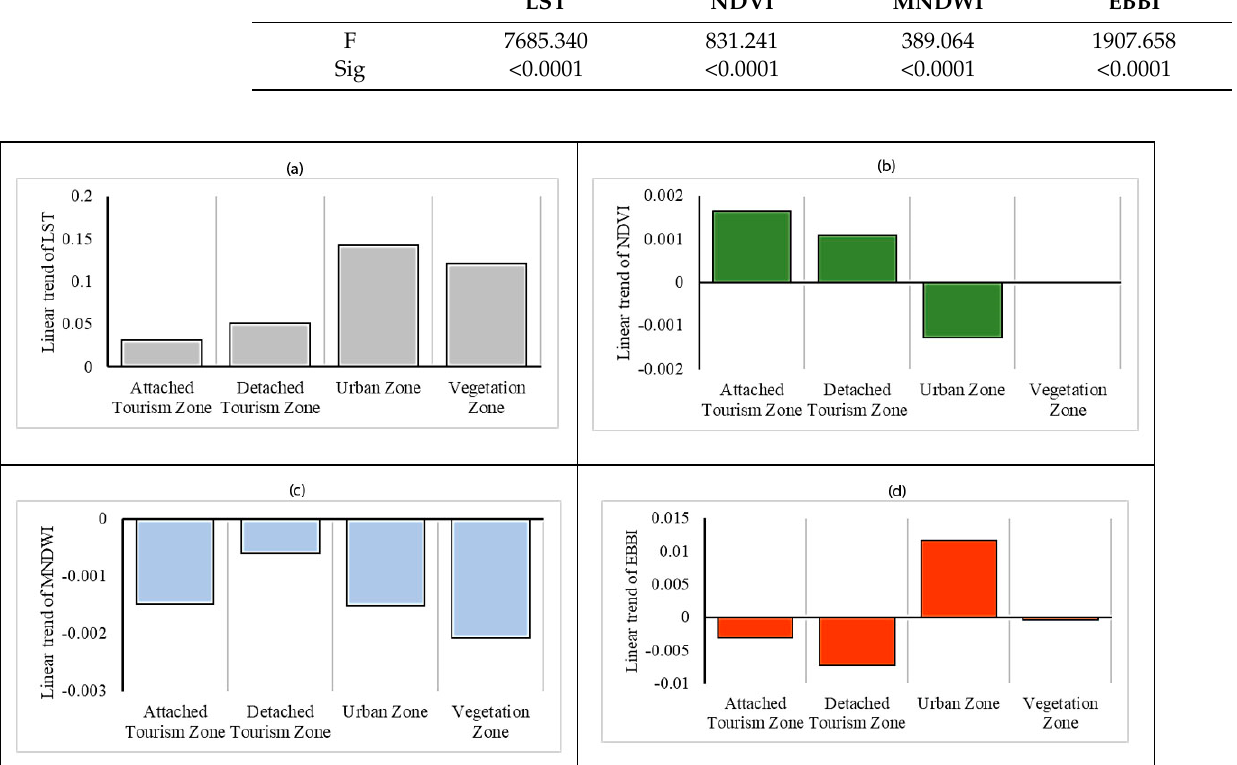
Figure 12. Average trend of 32-year changes in the LST ( a ), NDVI ( b ), MNDWI ( c ) and EBBI ( d ) in each of the zones. Table 9. Pair comparison of the average trend of 32-year changes in the LST, NDVI, MNDWI and EBBI indices in the zones based on Tukey (HSD) test